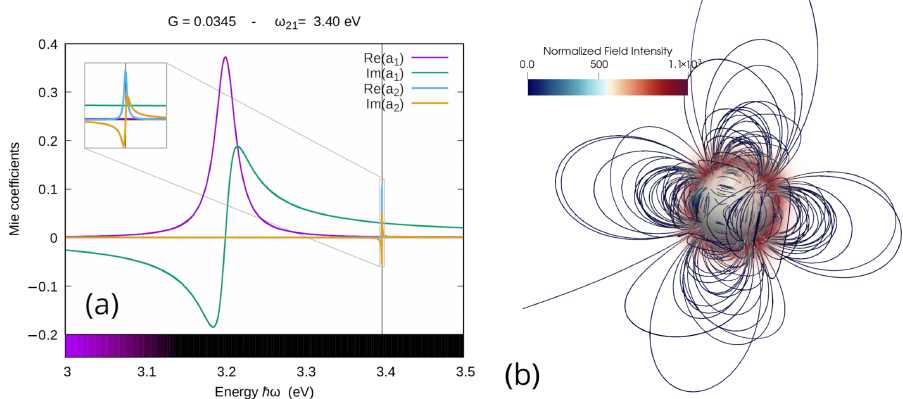
Figure 8. ( a ) Spectra for the real and imaginary part of the first two coefficients of the Mie expansion of the scattered field for a silver nanoparticle of radius 60 nm in water enriched with a gain medium below the emission threshold G = 0.03 with emission bandwidth ∆ = 0.15 eV. Here, the emission central frequency ¯ h ω 21 = 3.4 eV was chosen to correspond to the resonance frequency of the quadrupolar mode, the inset in the upper left corner is a zoom around the resonance frequency of the second coefficient; ( b ): streamlines of the scattered field calculated for the quadrupole central frequency, and the colorbar range here is the same as Figure